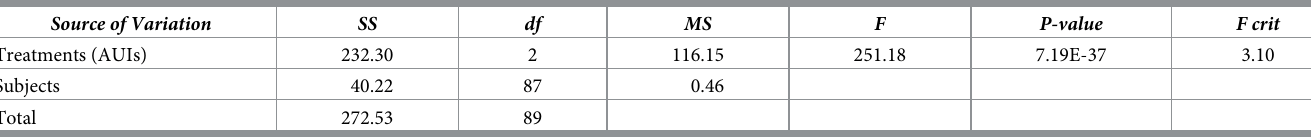
Table 10. One-way ANOVA—Viewpoint #1. Source of